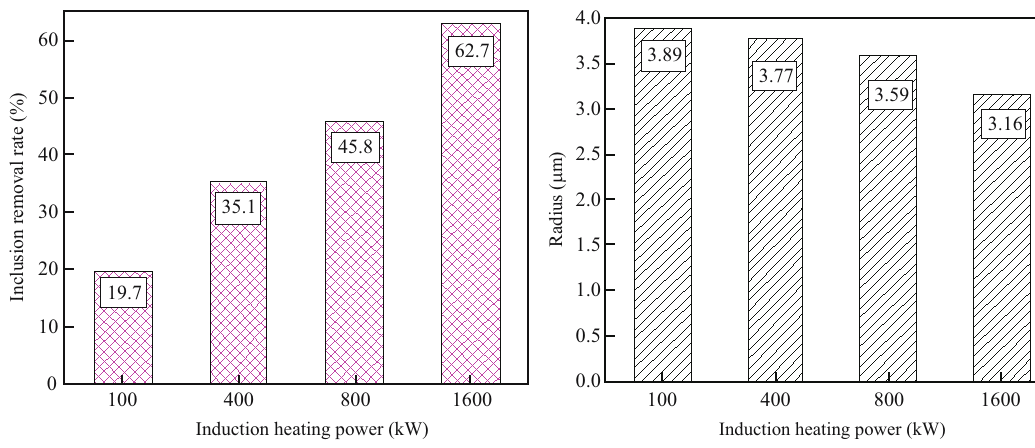
Figure 5: Inclusion removal rate and characteristic inclusion radius of tundish with di ff erent